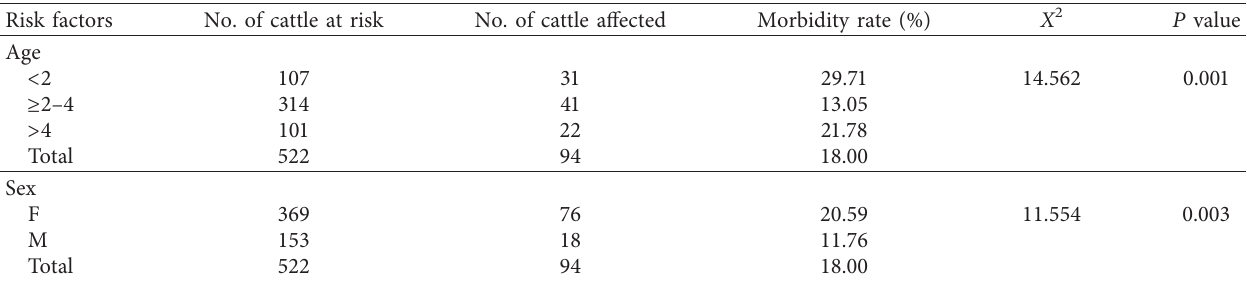
Table 2: LSD morbidity rate in different age and sex groups.